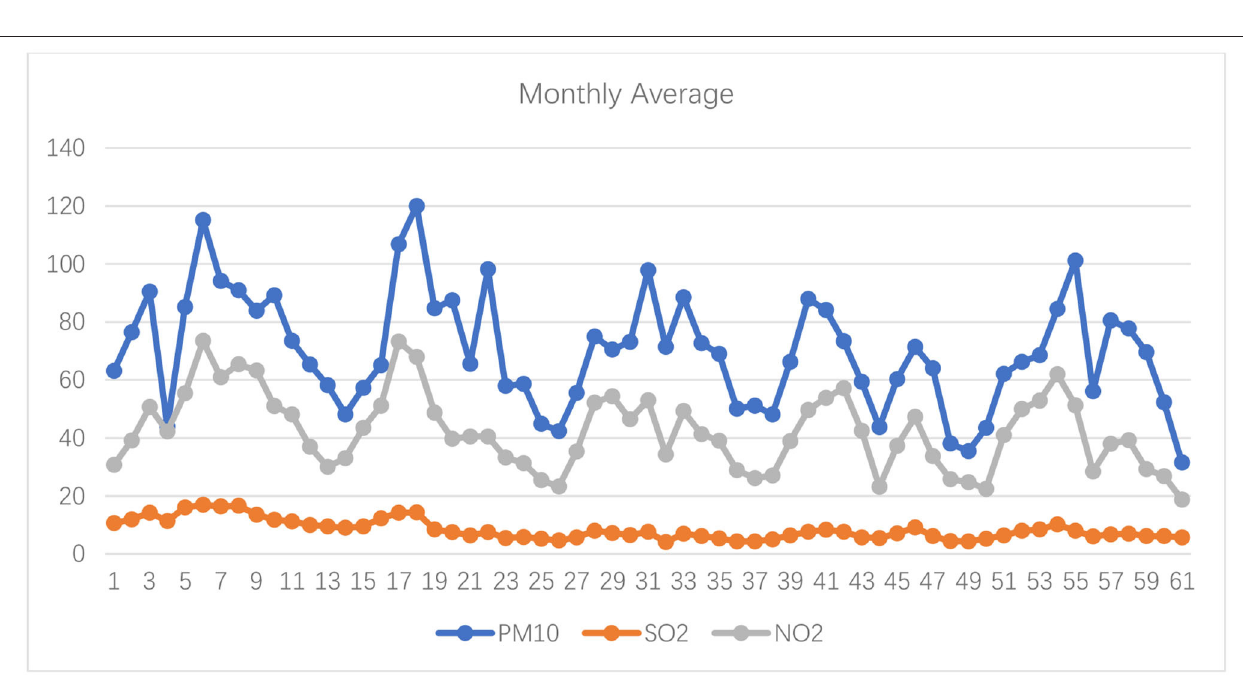
factor. When r ij appears negative, it is stipulated that r ij =